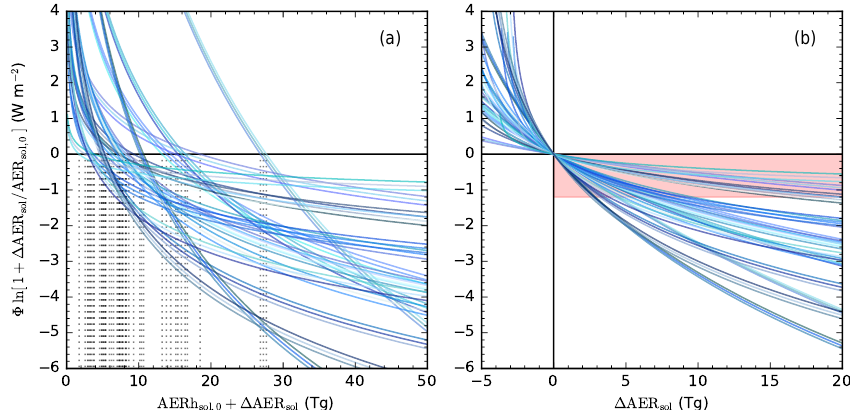
Figure 4. Ensemble of possible parameterizations of the aerosol–cloud interactions in OSCAR (Sect. 2.9.2). Here we show the simulated radiative forcing as a function of the total burden of soluble aerosols (left-hand side) or of the change in that burden since preindustrial times (right-hand side). In the former case, the grey dotted lines show the preindustrial burden we calculate; in the latter, the red area shows the 90% range of RF provided by Myhre et al. (2013b), and therefore the associated change in burden implied by our